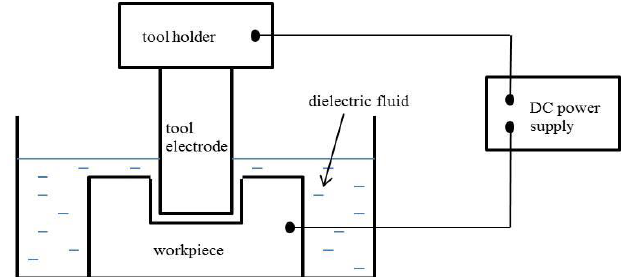
Figure 1: Schematic diagram of